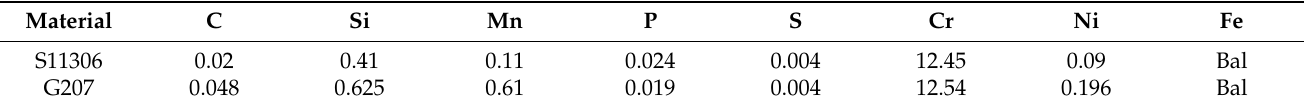
Table 1. Chemical composition of S11306 ferritic stainless steel and covered electrode G207.